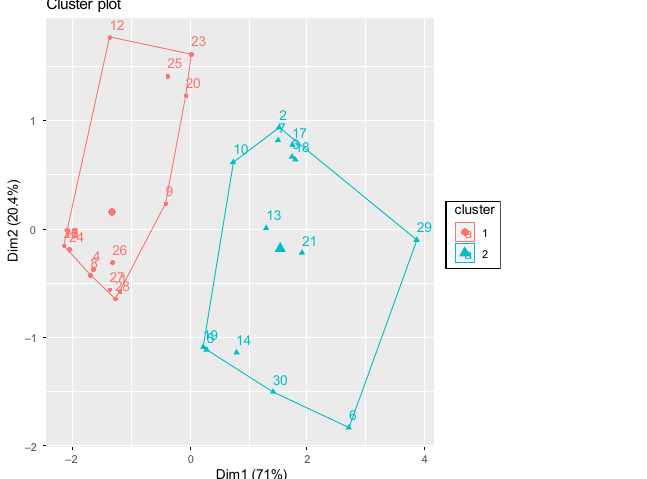
Figure 5. Scatter plot cluster of